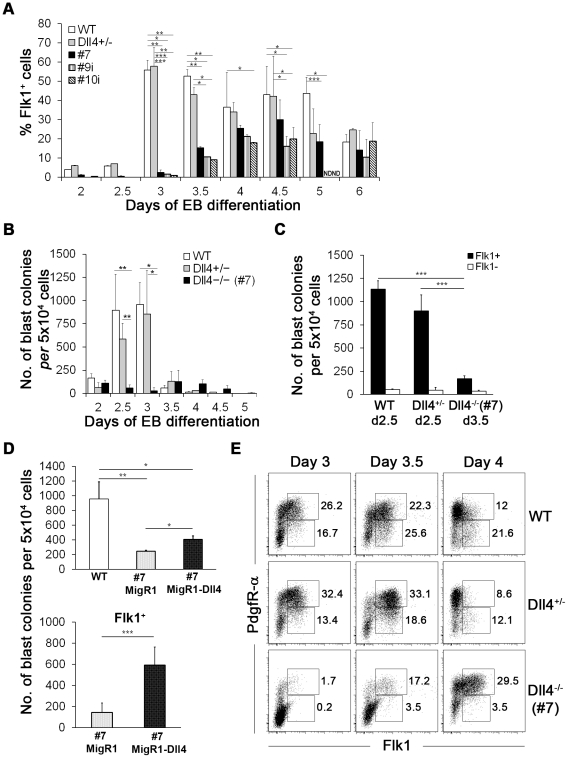
Analysis of Flk1 expression and BL-CFC potential of WT and Dll4 mutant EBs.(A) Flow cytometry analysis of Flk1 expression in WT, Dll4+/− and Dll4−/− EBs from day 2 to day 6 of differentiation. (B) Number of blast colonies generated by WT, Dll4+/− and Dll4−/− EB cells from day 2 to day 5 of differentiation. (C) Number of blast colonies generated by sorted Flk1 cells derived from day 2.5 WT and Dll4+/− EBs and from day 3.5 Dll4−/− EBs. (D) Number of blast colonies generated by day 3 EBs (upper) or sorted Flk1 cells (bottom) differentiated from WT and Dll4−/− ES cells transduced with empty (pMigR1) or recombinant virus (pMigR1-Dll4). (E) Representative flow cytometry dot-plot of Flk1/PdgfR-α expression from day 3 to day 4 of WT, Dll4+/− and Dll4−/− EBs (Flk1+/PdgfR-α+: day 3 - WT and Dll4+/−
versus #7, 0.00060<P<0.0406; Flk1+/PdgfR-α−: day 3 to day 4 - WT and Dll4+/−
versus #7, 0.0002<P< 0.0094; day 4 - WT versus Dll4+/−, P = 0.0457). ND not determined. *P<.05, **P<.01, ***P<.001.